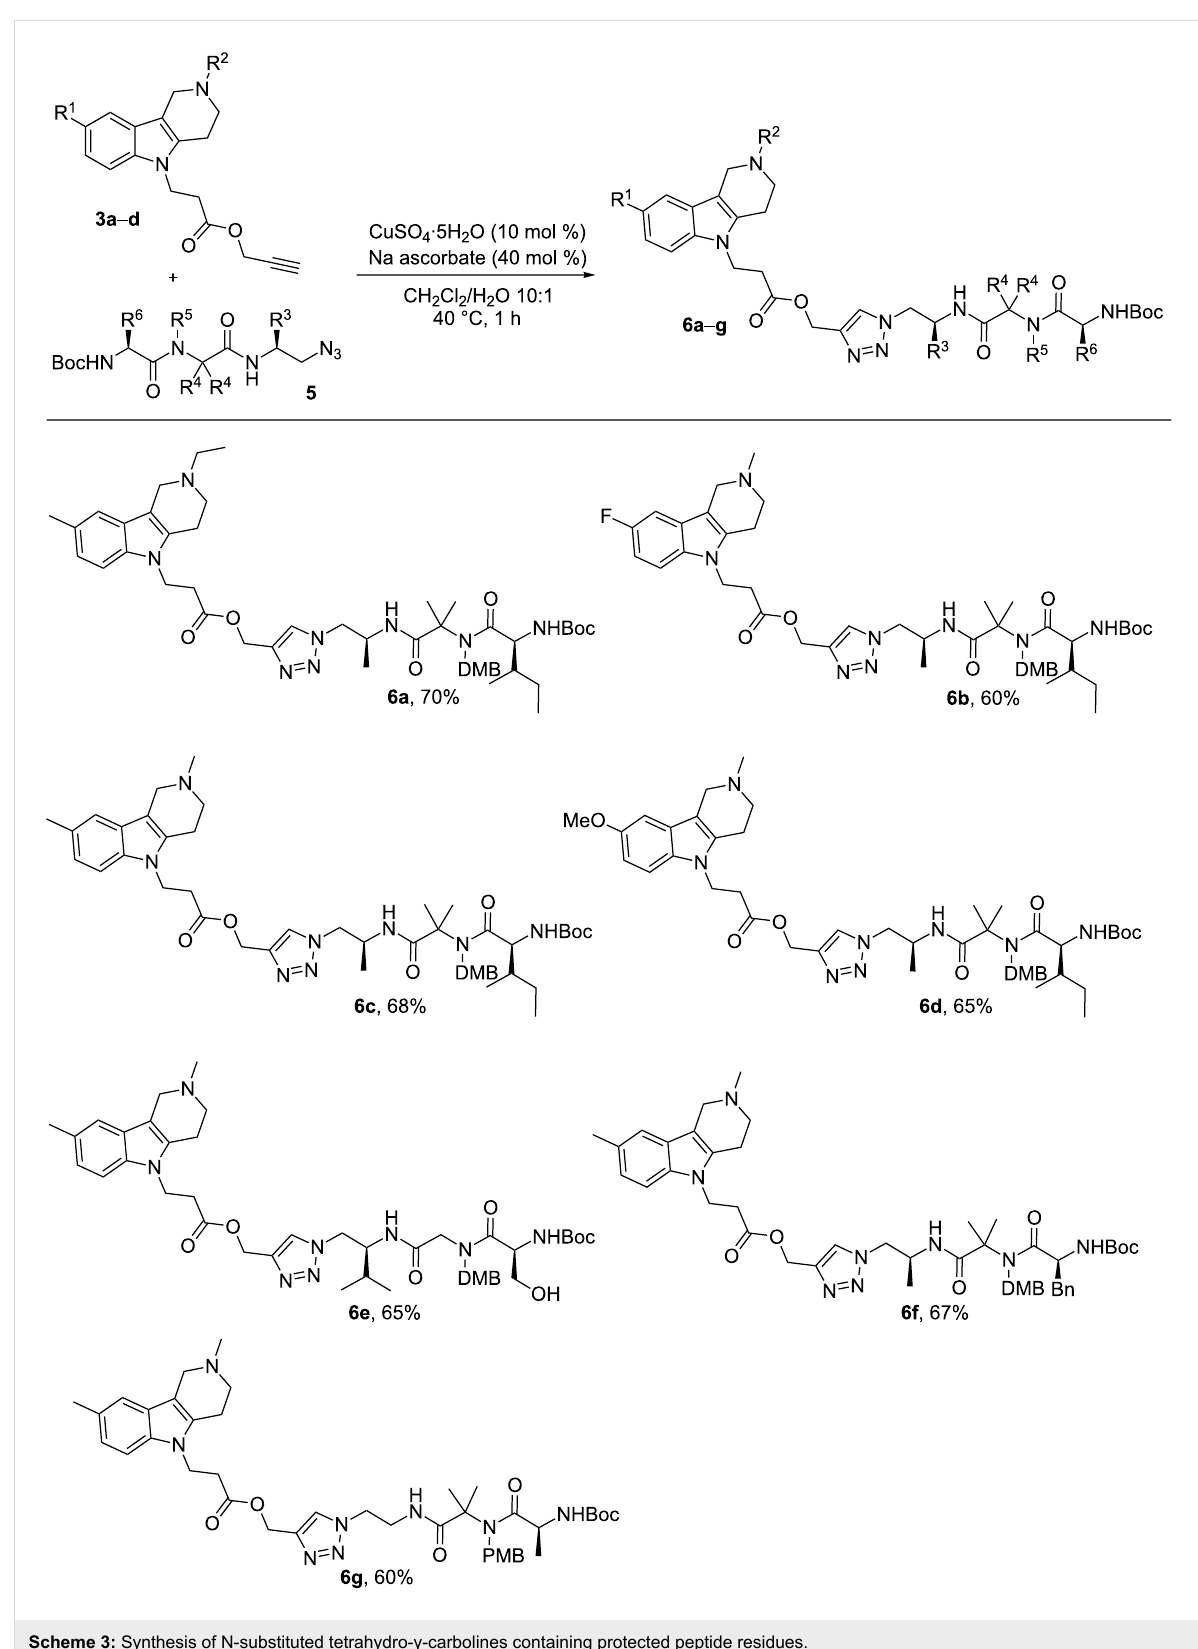
Scheme 3: Synthesis of N-substituted tetrahydro- γ -carbolines containing protected peptide